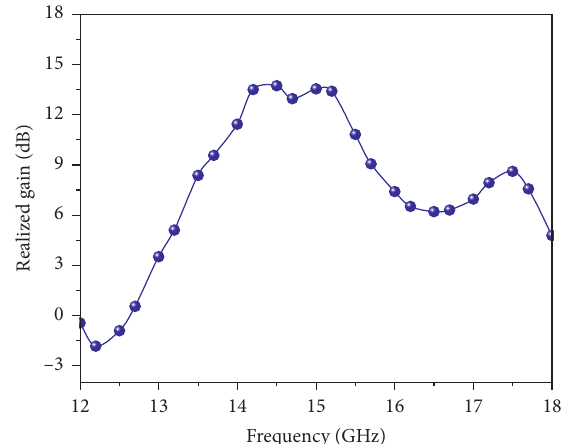
Figure 4: Realized gain spectrum for the single-layer metasurface- based antenna.